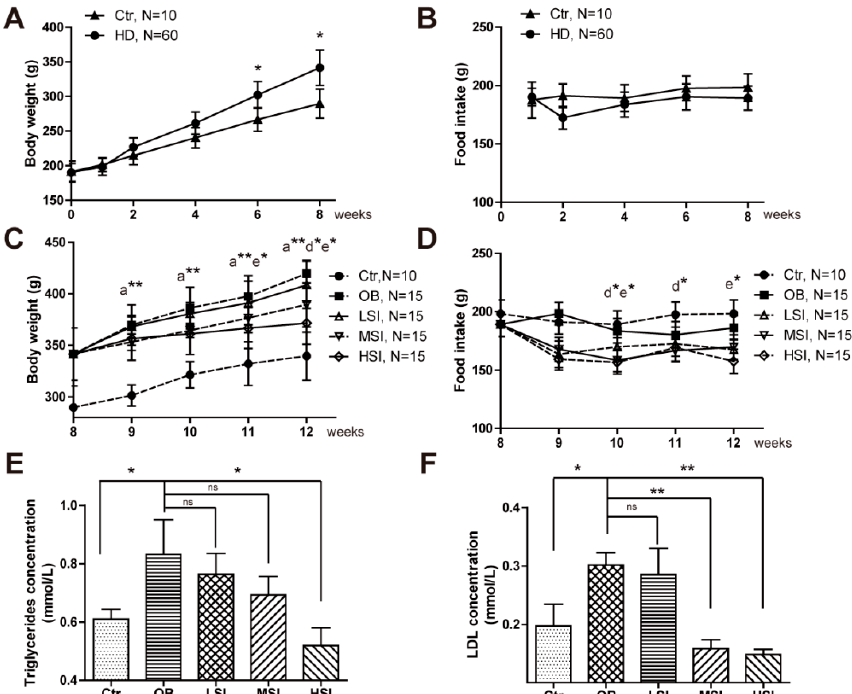
Figure 1. Soy isoflavones reduce the body weight, as well as the plasma TG and LDL concentrations. ( A ) Quantification shows the body weight of rats feed with basal diets and high fat diets; ( B ) Quantification shows no difference in food intake of rats feed with basal diets and high fat diets; ( C ) Quantification shows the body weight trend of DIO rats feed with basal diets and the addition with different doses of soy isoflavones. a**: b vs. a, p < 0.01; d*: b vs. d, p < 0.05; e*: b vs. e, p < 0.05; ( D ) Quantification shows the food intake trend of DIO rats feed with basal diets and the addition with different doses of soy isoflavones. d*: a vs. d, p < 0.05; e*: a vs. e, p < 0.05; ( E ) Quantification shows the triglycerides concentration of DIO rats feed with basal diets and the addition with different doses of soy isoflavones; ( F ) Quantification shows the LDL concentration of DIO rats feed with basal diets and the addition with different doses of soy isoflavones. Error bars indicate SEM. Significant difference in: a control group, b obesity group, c low-dose soy isoflavones group, d middle-dose soy isoflavones group, e high-dose soy isoflavones group. ns, no statistical significance, * p < 0.05, ** p < 0.01.